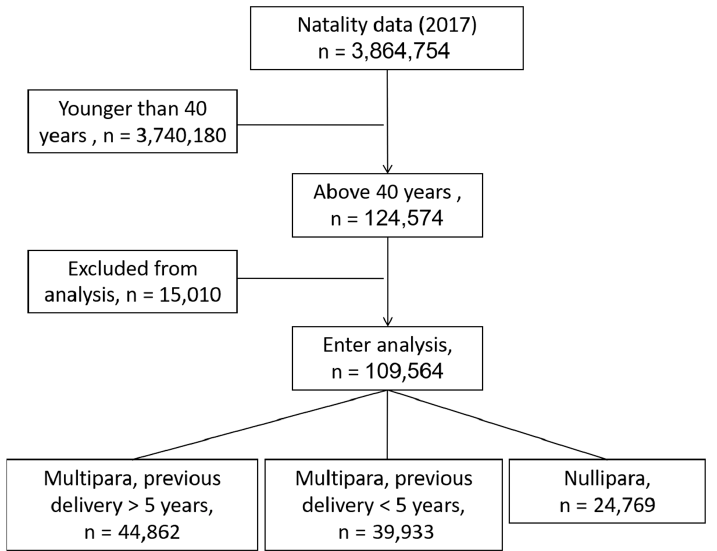
Figure 1. Flow chart of patients in each cohort after applying exclusion and inclusion criteria.